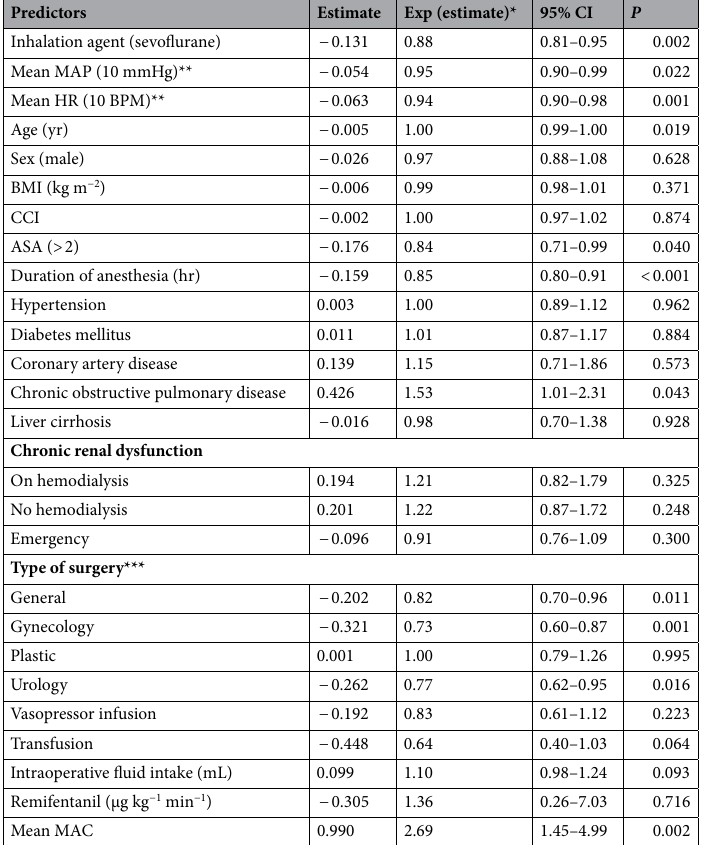
Table 3. Summary of the generalized linear mixed model. MAP mean arterial pressure, HR heart rate, BPM beat per minute, BMI body mass index, CCI Charlson comorbidity index, ASA American Society of Anesthesiologists physical status, MAC minimum alveolar concentration. *Exponential of the estimate. **Re-scaled using tenfold multiplication. ***Otolaryngological surgery was considered